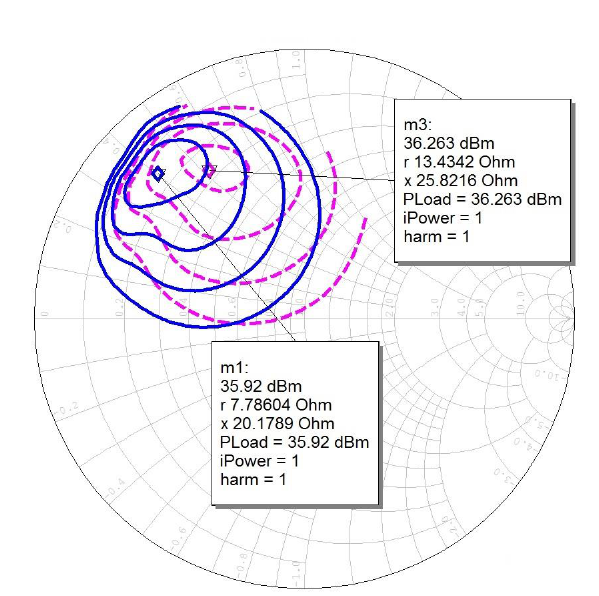
Figure 2: Load pull simulation results for two transistors size 6x125 μm (purple dashed line) and 8x125 μm (blue solid line)